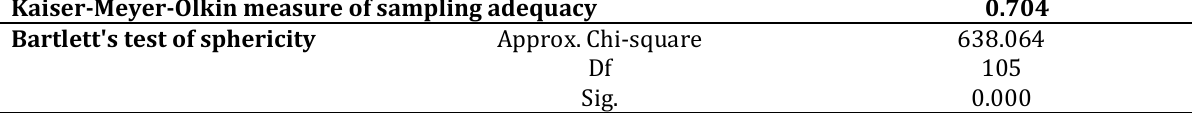
Table 6: KMO and Bartlett's Test of passenger traffic at domestic airports Kaiser-Meyer-Olkin measure of sampling adequacy